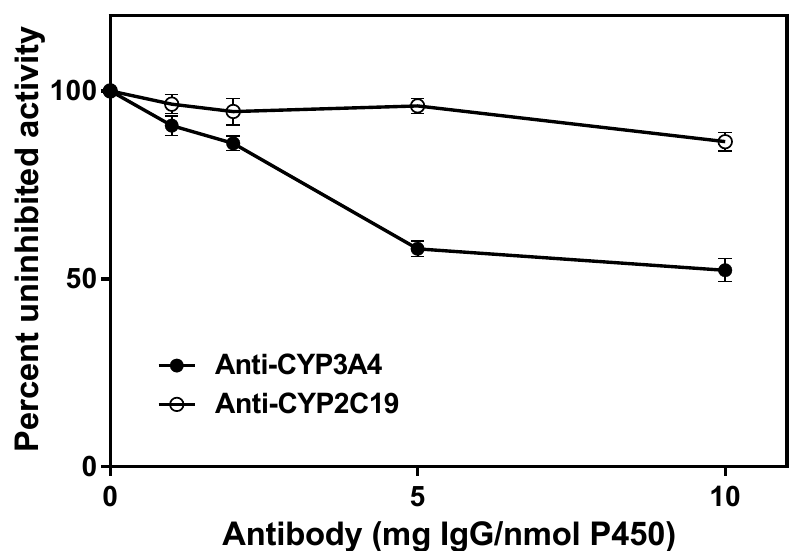
Figure 7. Immunoinhibition of antibodies against CYP3A4 on OA hydroxylation activity in HLMs. The effects of anti-CYP3A4 ( • ) and anti-CYP2C19 IgG ( examined. Values represent the mean ± SD of the three